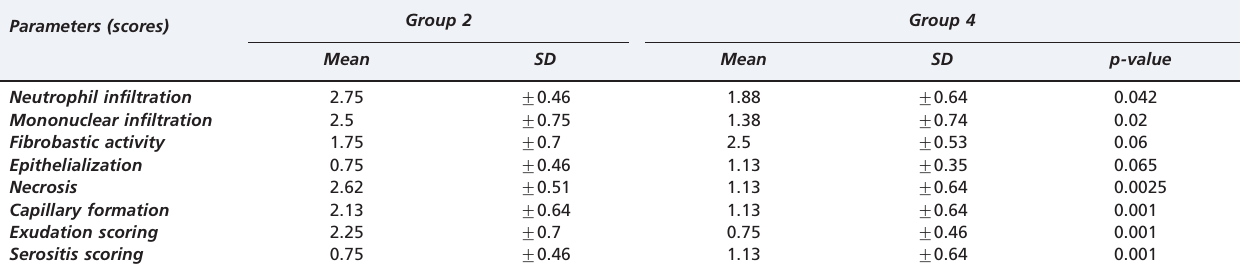
Table 4 - Histopathological differences between groups 2 and 4, sacrificed on postoperative day 7. Parameters